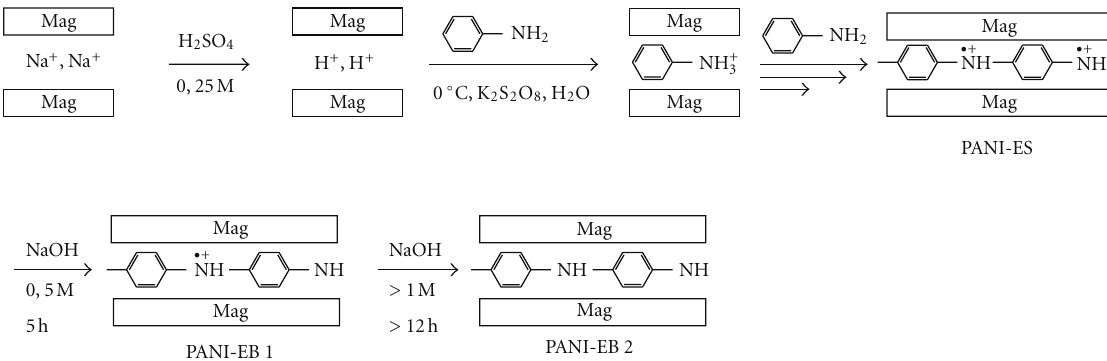
Scheme 1: Proposed process for soluble polyaniline catalysed Mag- H +